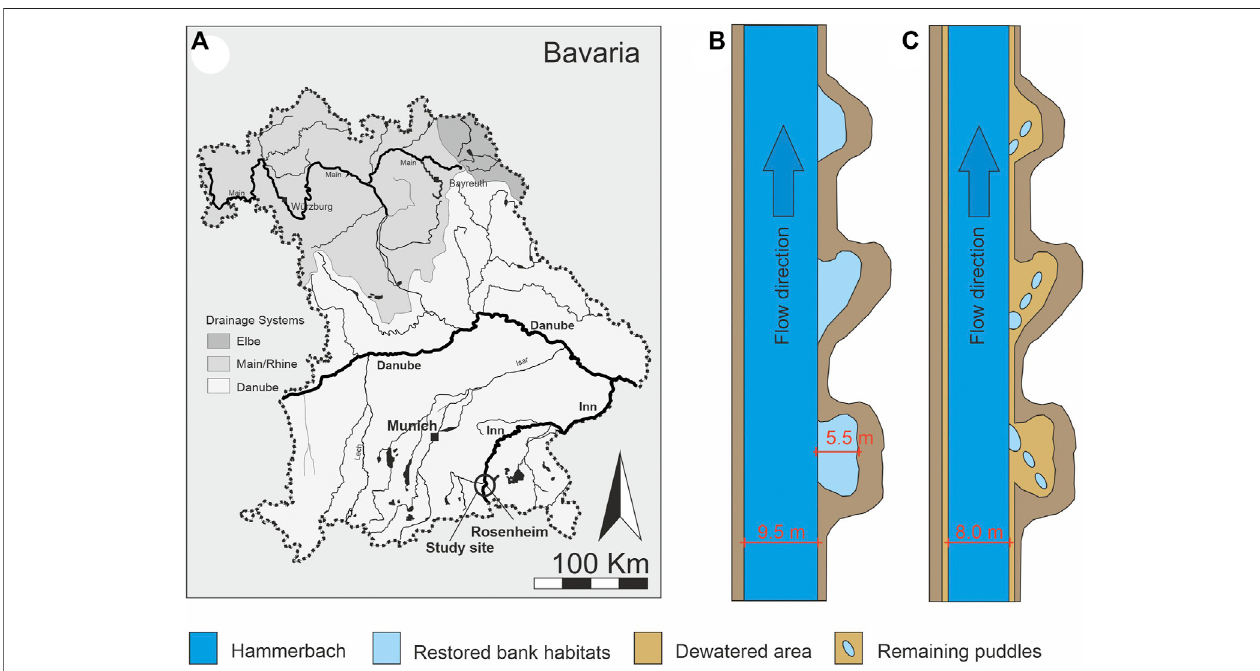
FIGURE 1 | Location of the study site within Bavaria, Germany (A) . Schematic top view of a principle Hammerbach stretch under the mean fl ow conditions (MQ) with fl ooded bank habitats (B) and under dewateringconditions (DQ) withpartly dry habitats (C) . Remaining puddles under dewatering conditions are indicated in panel (C) in light blue. River width of the Hammerbach and width of the bank habitats are given as the mean. Water levels of MQ and DQ are indicated in the side view of Figure 3 .